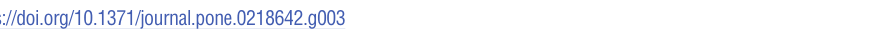
Fig 3. ROC curves (colored) and average ROC-curve (black dotted) over 10 random stratified shuffle-splits of the